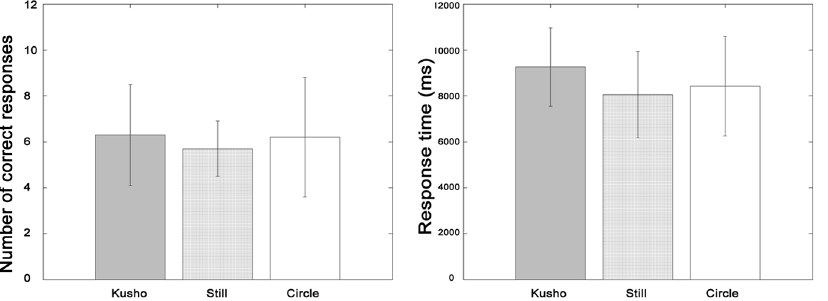
Fig 4. Correct response and response time in the replication task. The error bar indicates standard deviation. There were no significant effects at all.